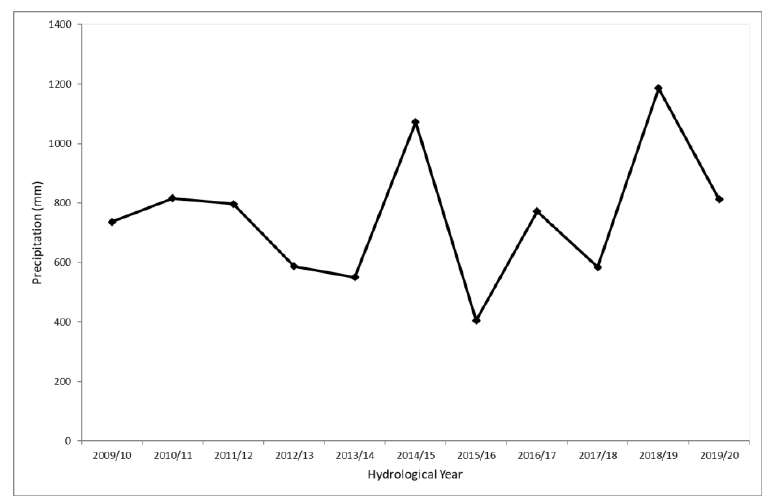
Figure 3. Annual average precipitation variation during the period 2009/10–2019/20. A full error analysis of the method’s capacity to estimate the annual precipitation values of the hydrological year 2016/17 at the 53 observation locations is presented in Ta- ble 1. As it can be observed by the estimation of metrics, the spatiotemporal residual kriging model that involves the sum-metric function delivers more accurate results com- pared to that which involves the product-sum. The difference might not be significant between the two variogram functions, but any enhancement is important for the improve- ment of the spatiotemporal variability estimation of physical variables. The bias scatter- plot (Figure 4) provides the error distribution among the estimated values using STRK and the sum-metric function.